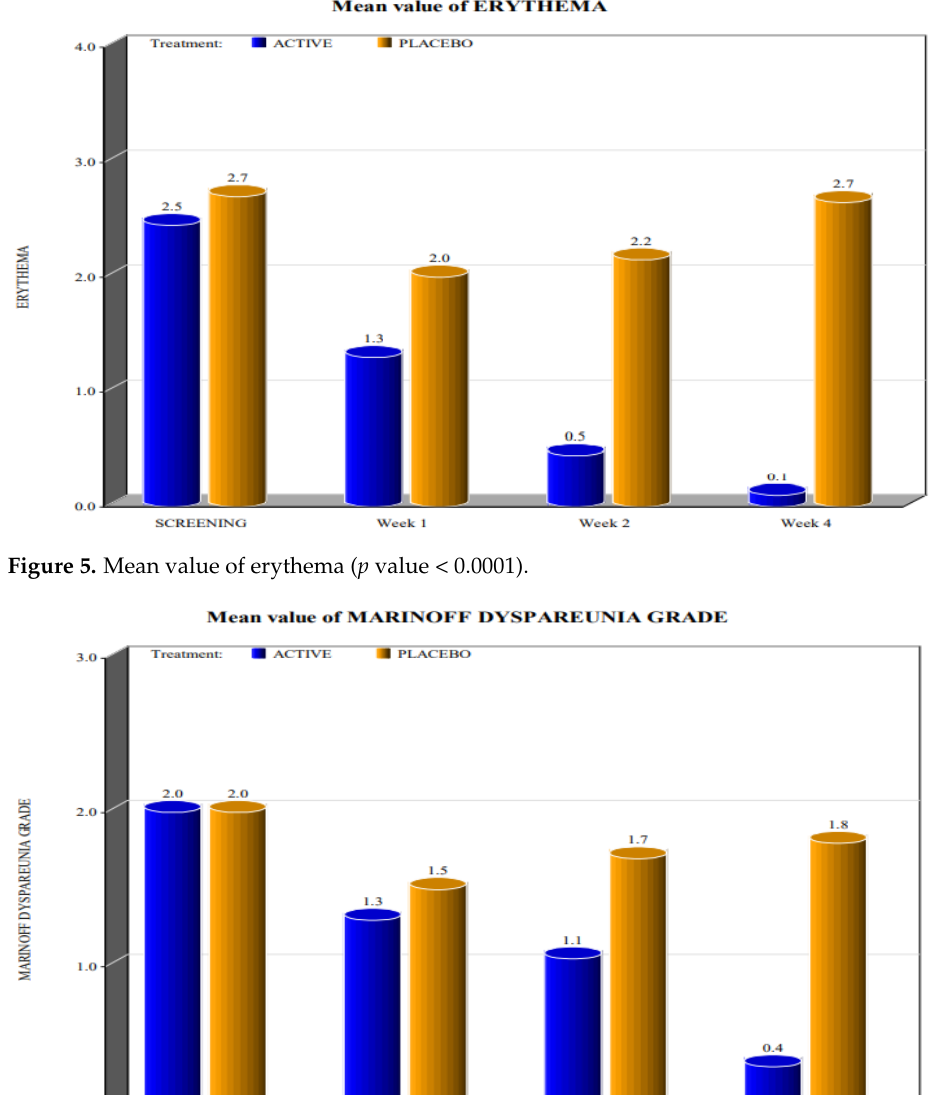
Table 3. Reduction of Marinoff dyspareunia from screening to week 1, week 2 and week 4. Parameter/Statistics